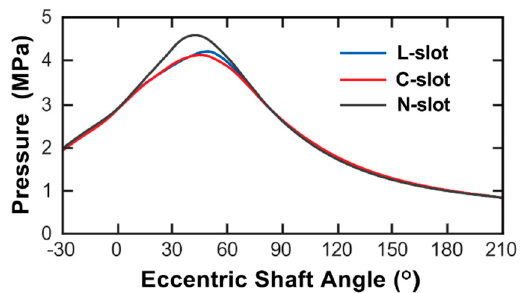
Figure 6. Simulated mean in-chamber pressure for L-slot (baseline), C-slot, and N-slot configurations.